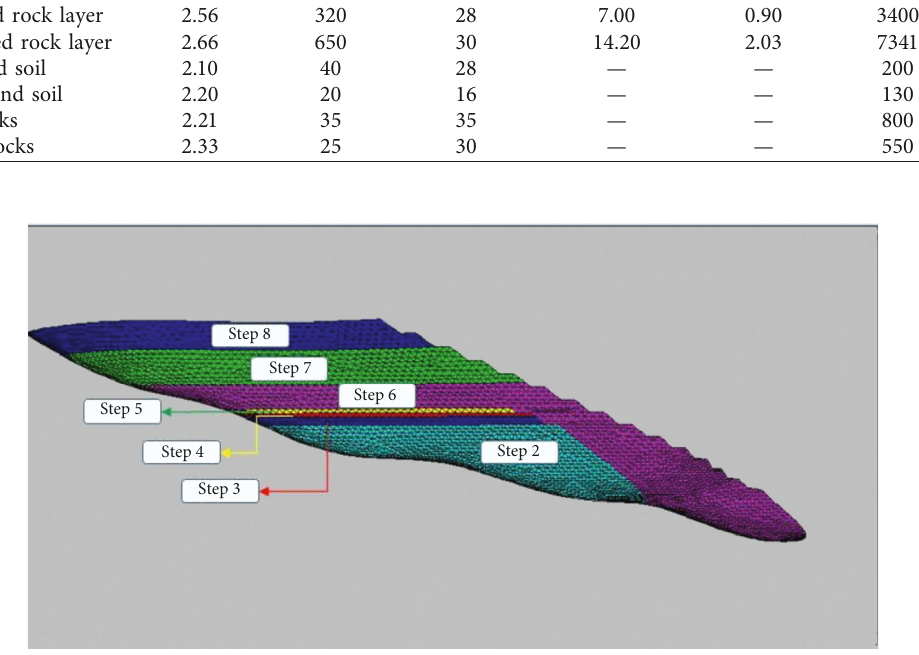
Figure 7: Schematic diagram of the numerical simulation for waste dump. Table 8: Analytical steps of 3D numerical simulation for waste